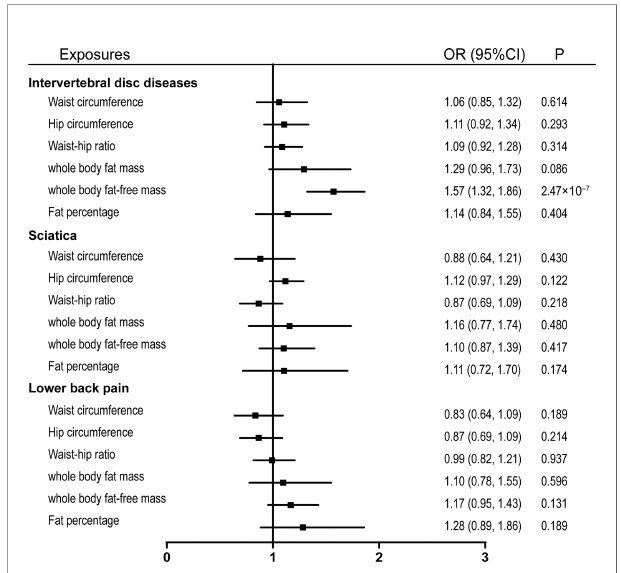
FIGURE 4 | Effects of obesity-related exposures adjusted for BMI. Results from multivariable MR analyses showing the effects of obesity-related traits on IVDD, sciatica, and LBP after adjusting for the effect of BMI. BMI, body mass index; OR, odds ratio; CI, con fi dence interval; MR, Mendelian randomization; IVDD, intervertebral disc degeneration; LBP, low back pain.